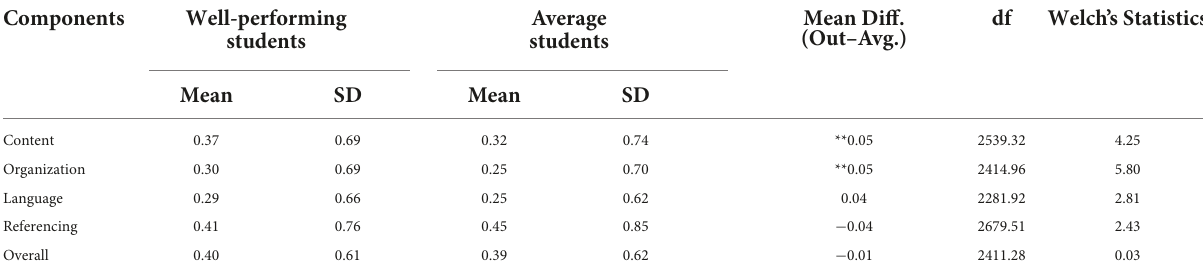
TABLE 6 Progression of students (by overall grade).